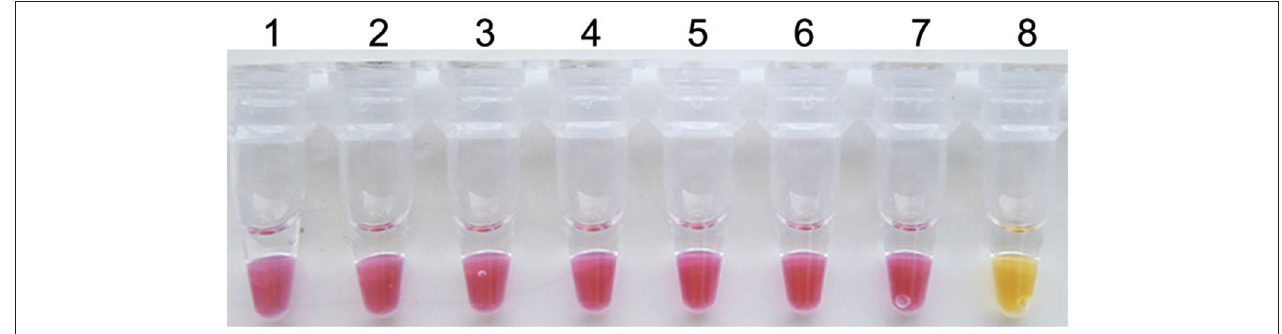
FIGURE 2 | Specificity of the colorimetric IMSA assay for PCV3. Tubes 1–6, DNA of PCV2, PCV1, PRV GD-WH strain, HPS, SS, and APP. Tube 7, negative control. Tube 8, 10 5 copies of PMD19T-capsid plasmid